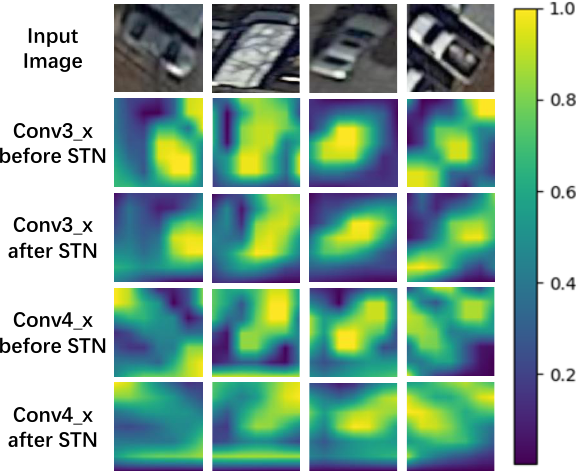
Figure 9. Feature map (one example per column). Colors show activation